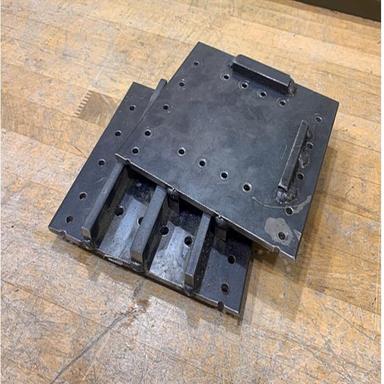
Handle of tensile test clamps.